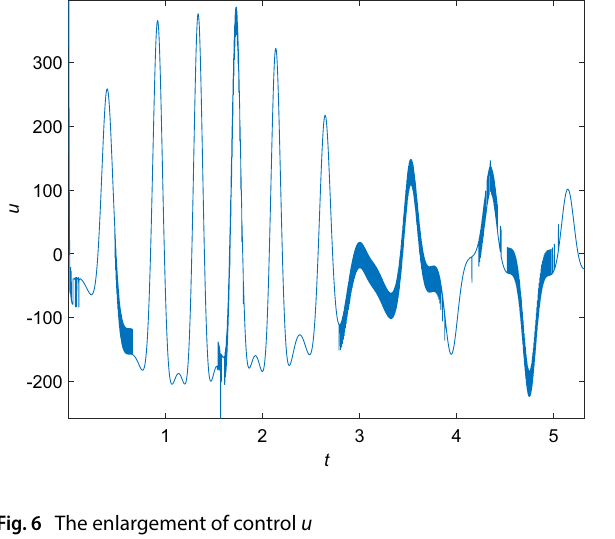
Fig. 9 The evolution of the synchronization errors